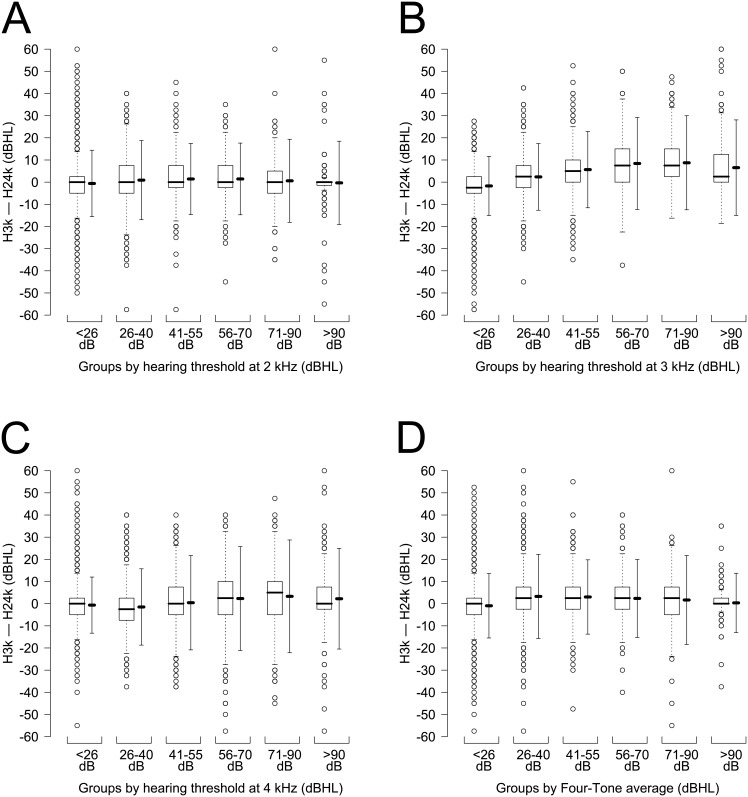
Box-and-whisker plot (left) for the mean difference and limit of agreement (right) of difference between the threshold at 3 kHz (H3k) and the average of thresholds at 2 kHz and 4 kHz (H24k) against the threshold groups. (A) 2 kHz; (B) 3 kHz; (C) 4 kHz; and (D) four-tone (0.5, 1, 2, and 3 kHz) average (weighted N = 39,357,497 × 2 ears).These graphs show that the degree of hearing thresholds at the three frequencies and at the four-tone average did not affect the distribution of the difference between H3k and H24k. However, the upper and lower limits of agreement are roughly greater than 10 dBHL and less than –10 dBHL, respectively. ※Threshold groups are divided as follows: normal (<26 dBHL), mild (26–40 dBHL), moderate (41–55 dBHL), moderately severe (56–70 dBHL), severe (71–90 dBHL), and profound (>90 dBHL); dBHL: decibel hearing level.